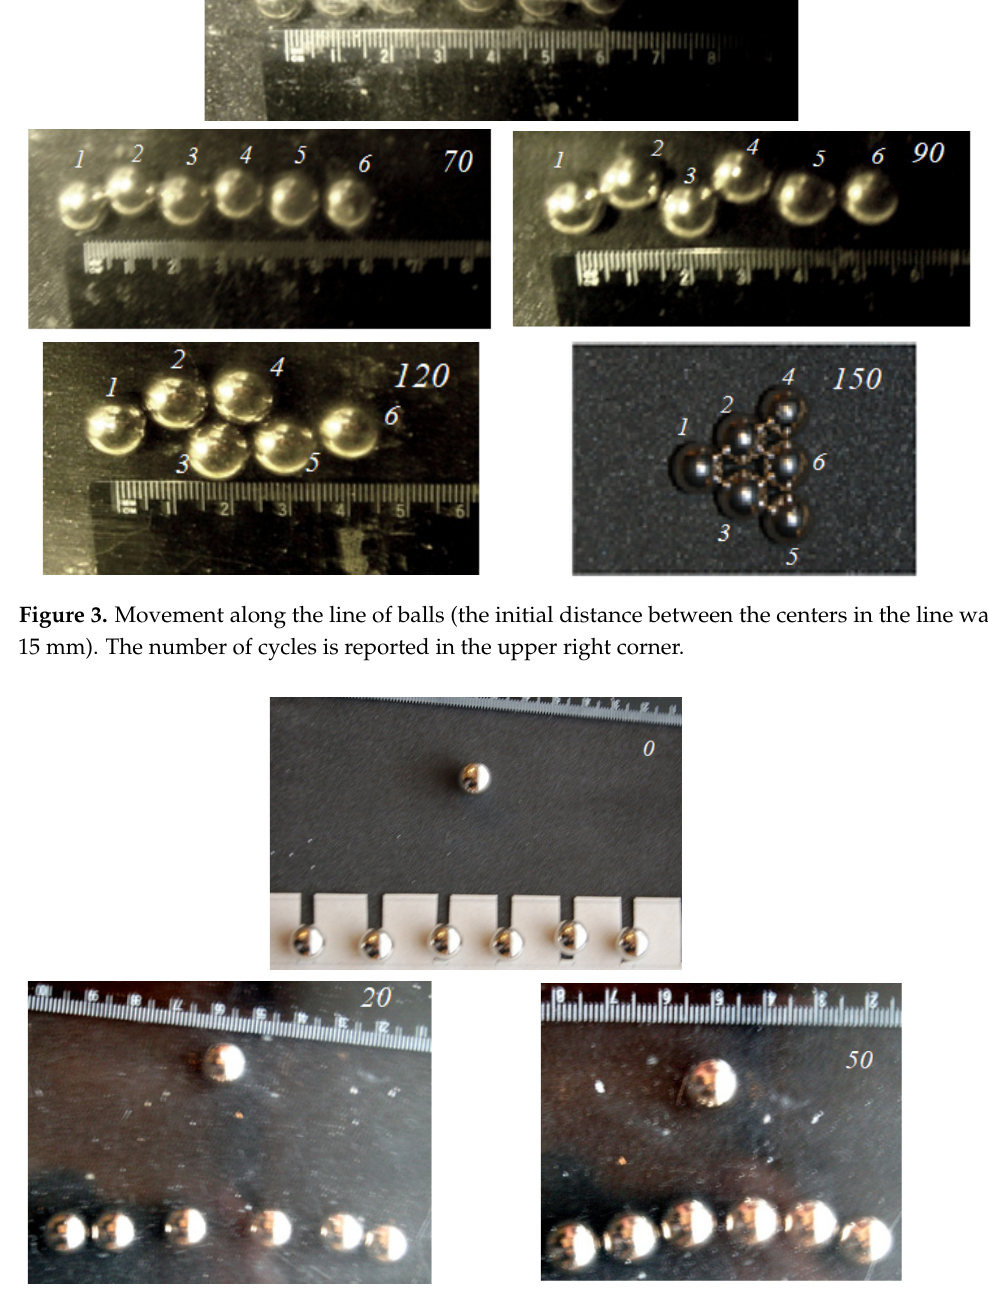
Figure 4. Reciprocating motion along the line of balls (the initial distance between the centers in the line was 15 mm). The number of cycles is reported in the upper right corner.